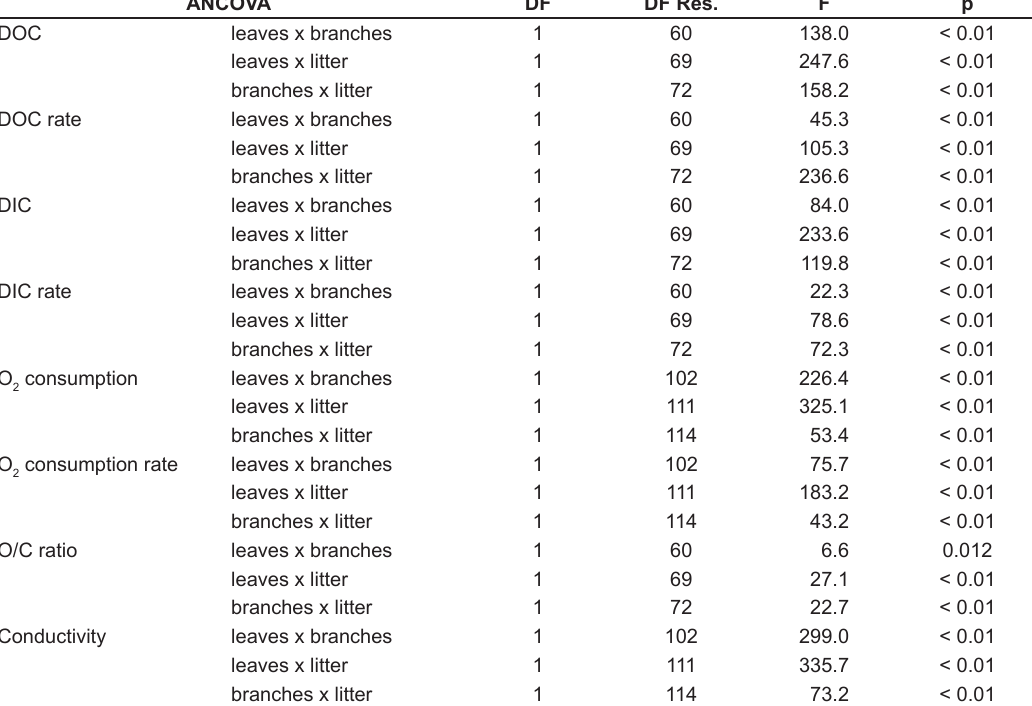
Table 1. Values of significance (p) of ANCOVA test, degrees of freedom (DF) and residual (DF Res.) and values of deviance (F) for DOC, DOC rate, DIC, DIC rate, O tivity between